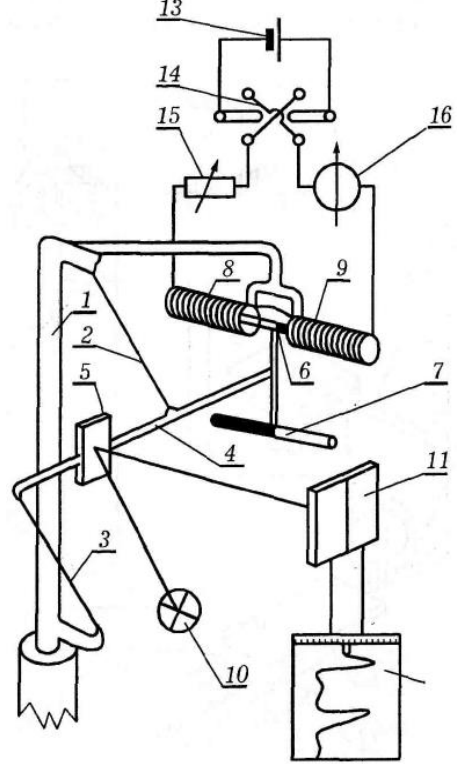
Fig. 2. Tiltmeter with control device and calibration using electromagnetic